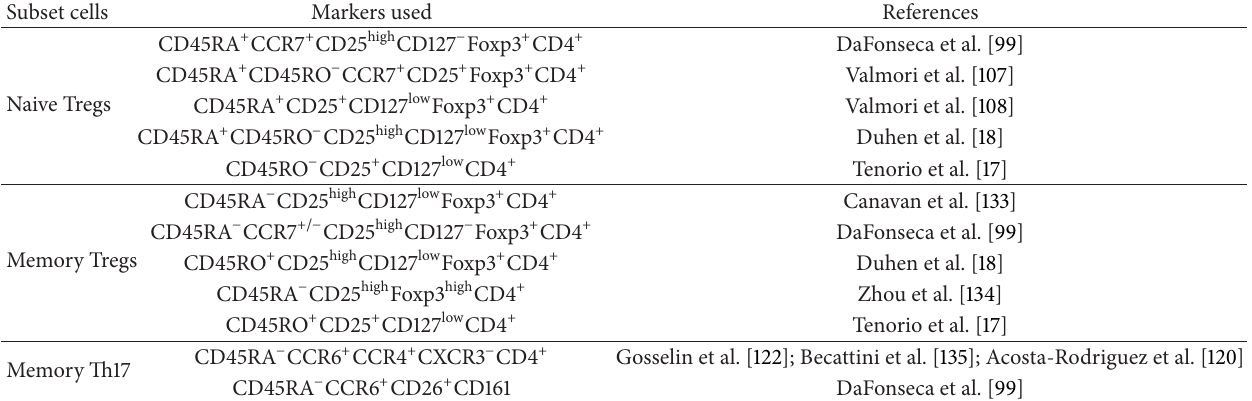
Table 1: Immunophenotyping of Treg and Th17 cells and their precursors in different studies. Subset